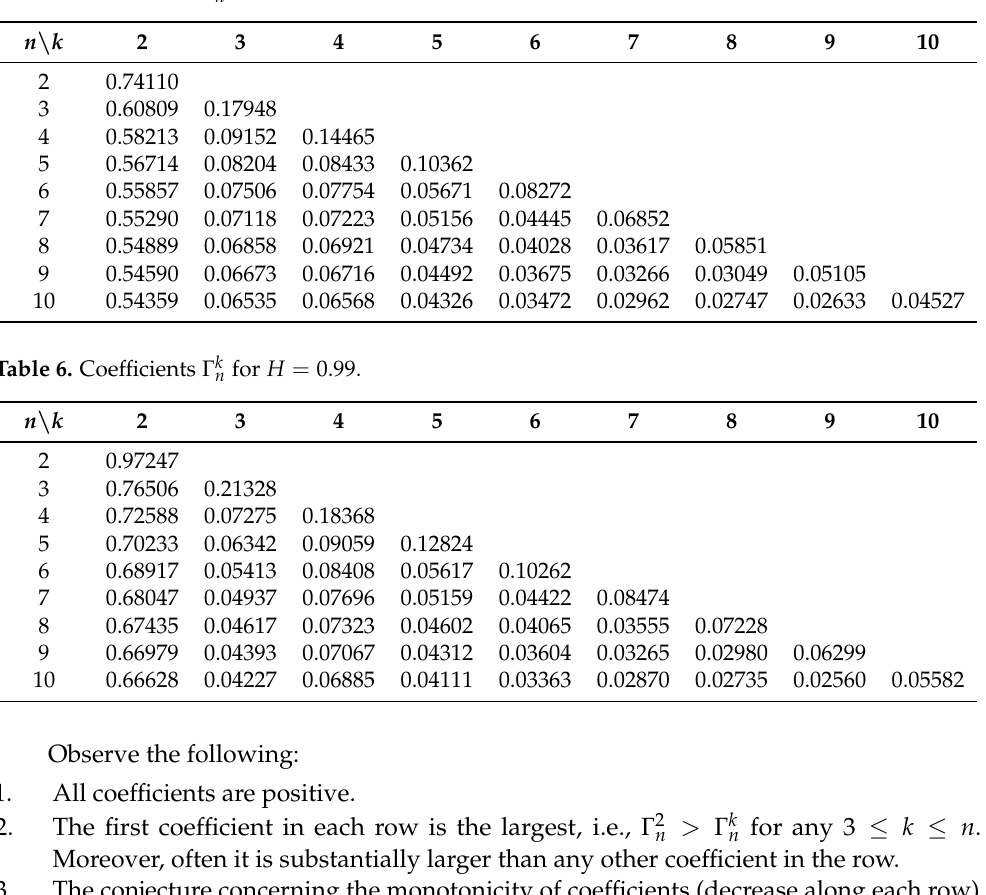
Table 5. Coefficients Γ k n for H = 0.9.